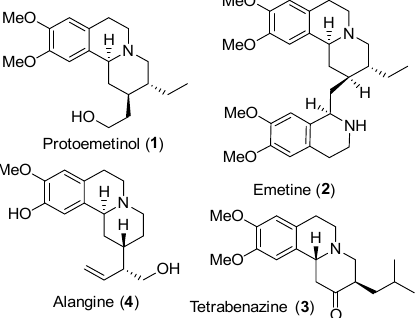
Figure 1. Examples of benzoquinolizidine alkaloids.